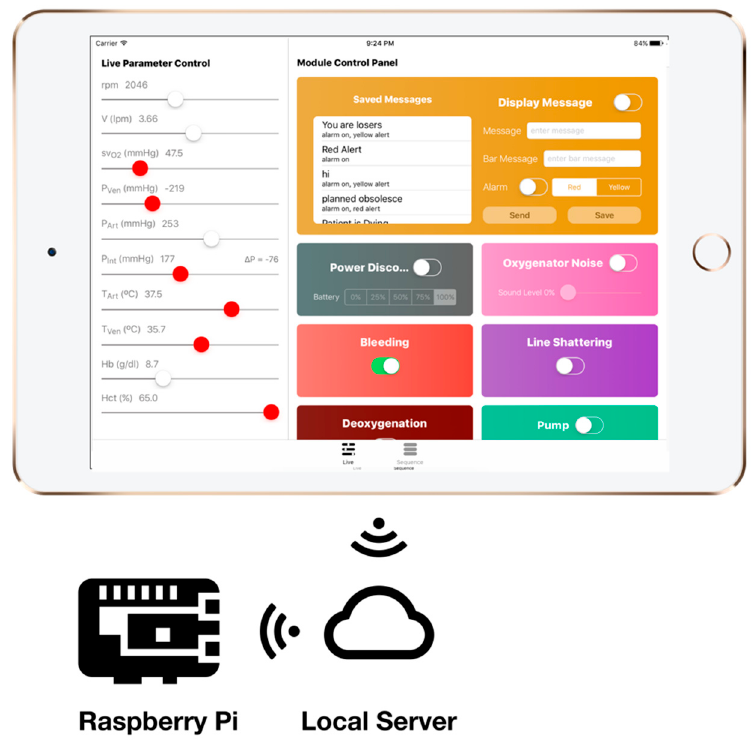
Figure 10. The instructor application.